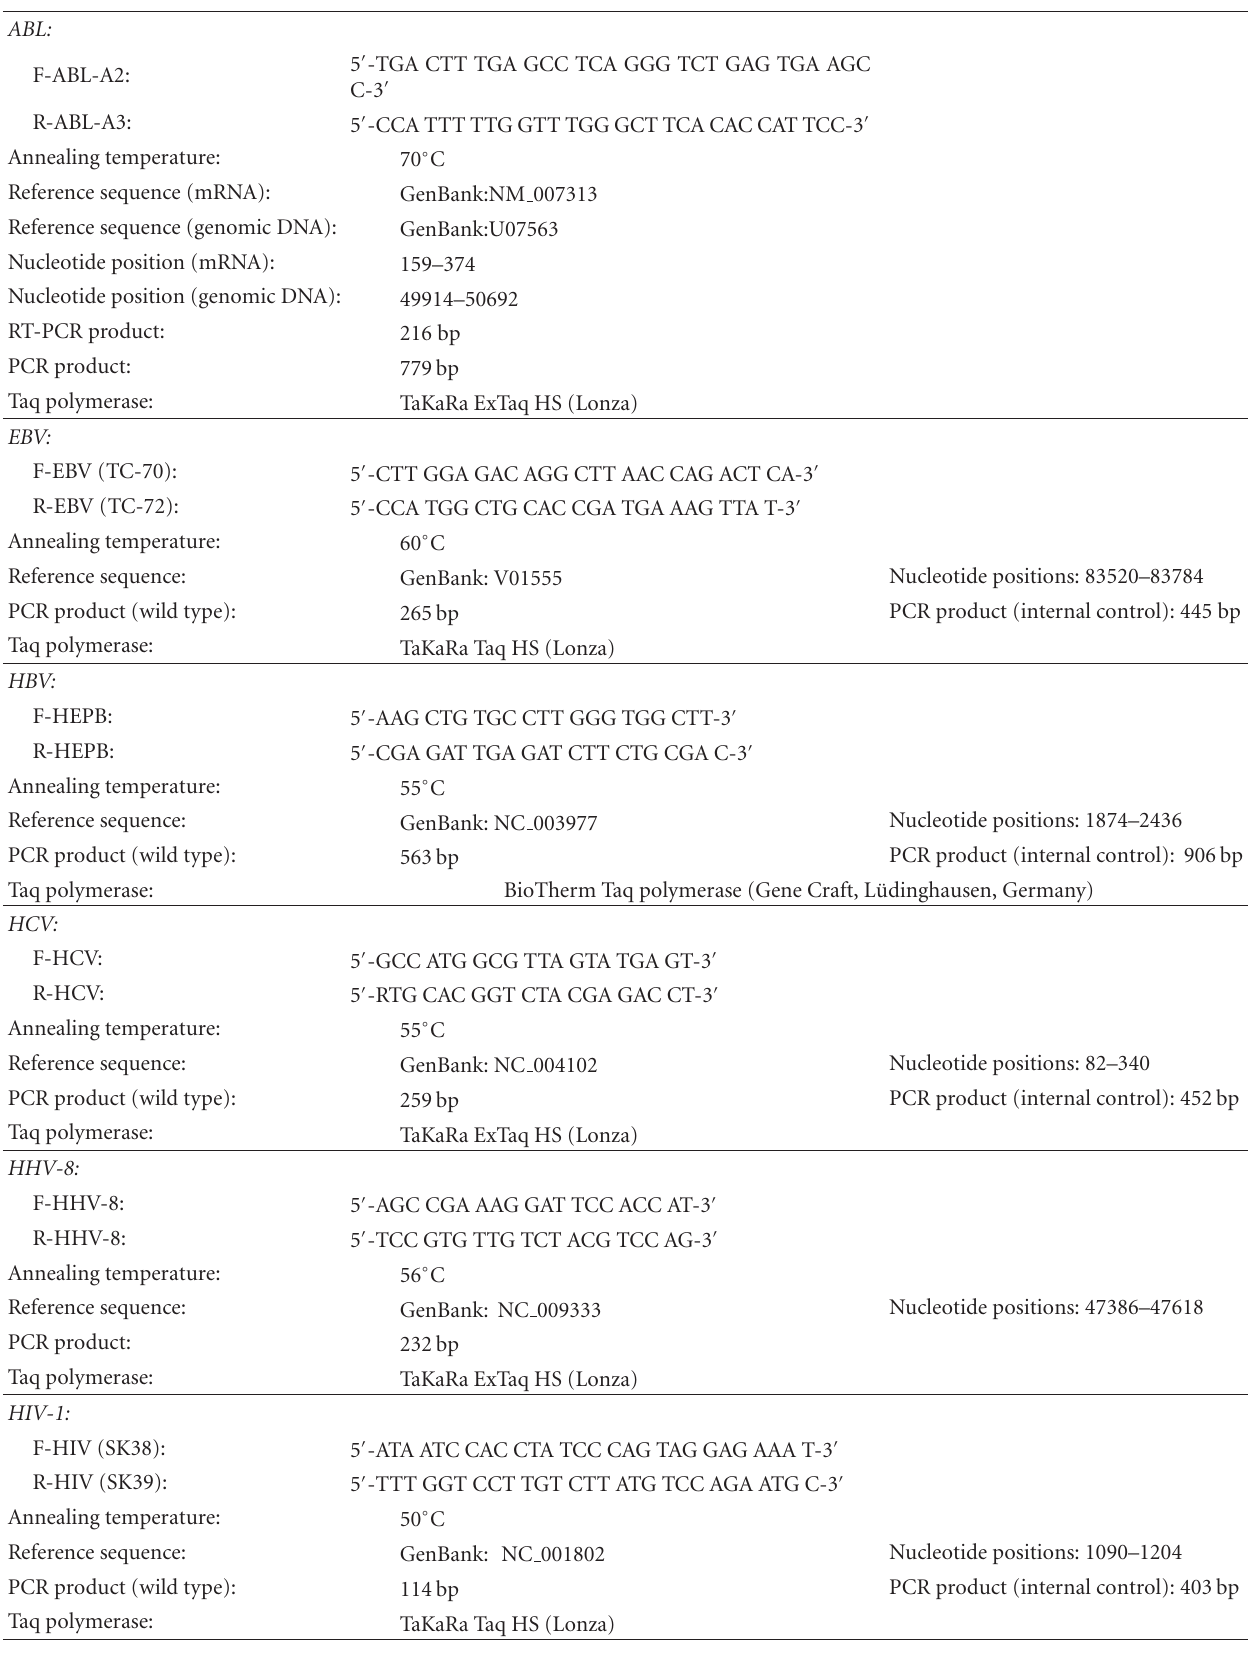
Table 1: Primer sequences and PCR product sizes of wild type and internal control